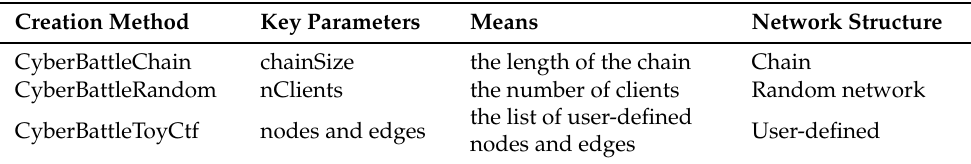
Table 2. Three methods for creating scenarios provided by CyberBattleSim. Creation